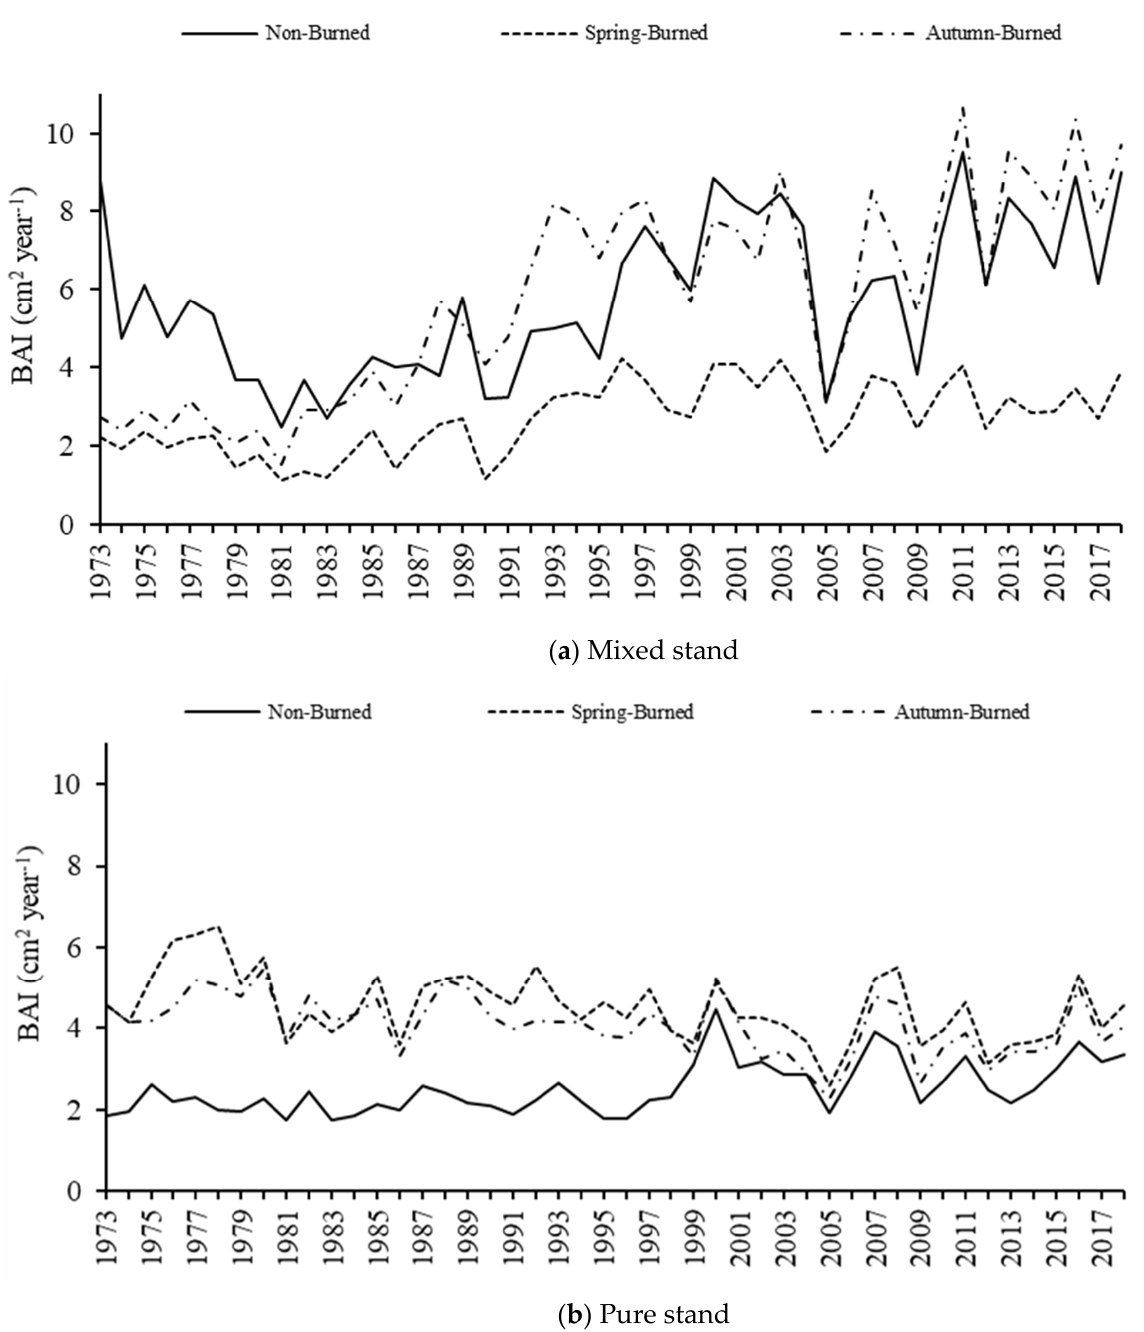
Figure 2. Comparison of annual trends in mean basal area increment (BAI) in ( a ) the mixed stand and in ( b ) the pure stand. Unburned plots (solid line), spring-burned plots (dashed line) and autumn-burned plots (dotted line). Spring burning was conducted in May 2016, autumn burning was carried out in November